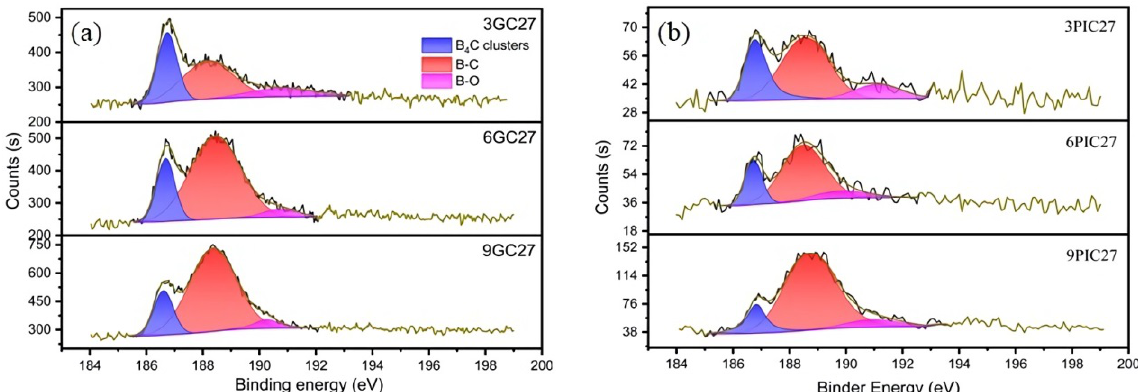
Figure 1. B1s XPS spectra of the boron-doped graphite studied. ( a ) Boron-doped graphite prepared using needle coke (GC) as raw material; ( b ) Boron-doped graphite prepared using pitch coke (PIC) as raw